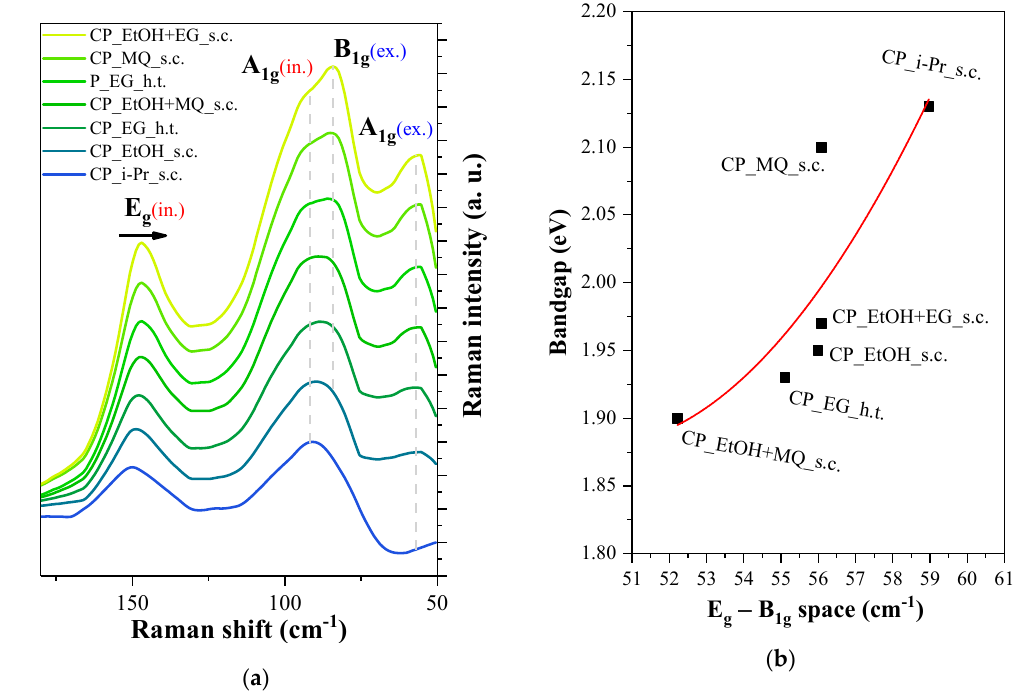
Figure 7. Raman spectra of the coated paper: the relationship between internal (A 1g ) and the external (B 1g ) Bi-I bond (a) , and its effect on the optical properties and the calculated bandgap (b) .